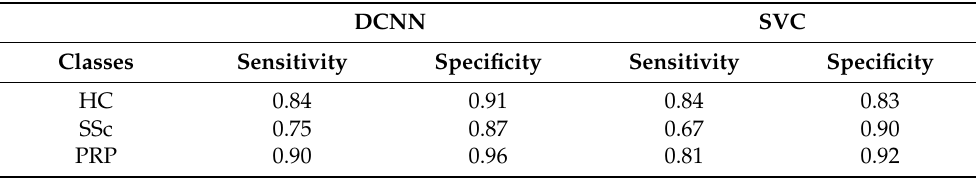
Table 2. Sensitivity and specificity of DCNN and SVC models on HC, SSc, and PRP participants’ classification.